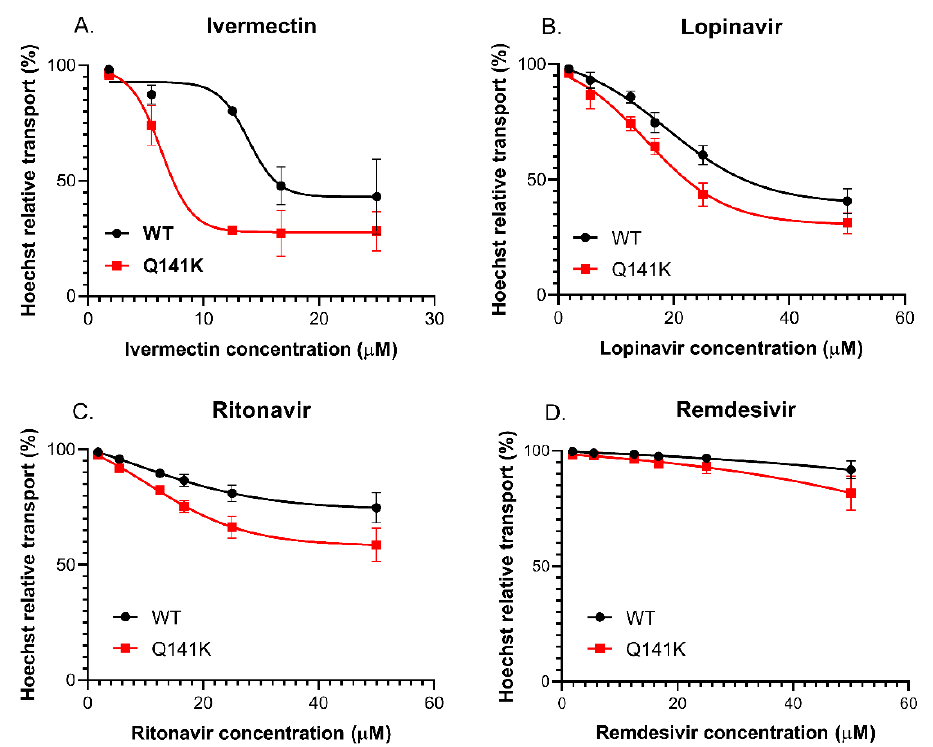
Figure 4. Hoechst 33342 dye extrusion in HeLa cells stably expressing the WT and Q141K variants of ABCG2. Different concentrations of ivermectin ( A ), lopinavir ( B ), ritonavir ( C ), and remdesivir ( D ) were used to determine their effect on ABCG2 function. Data on the graphs show the average of three independent experiments, +/- SD values.